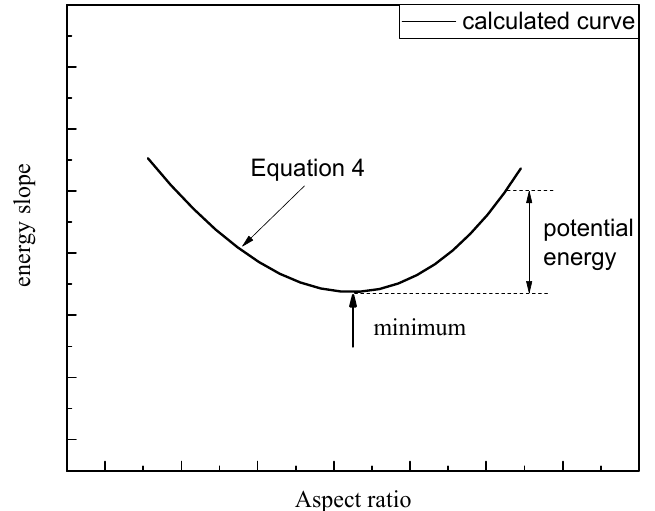
Figure 3. Plot of energy slope vs. aspect ratio for hydraulic geometry with constant Q , Q s , and d